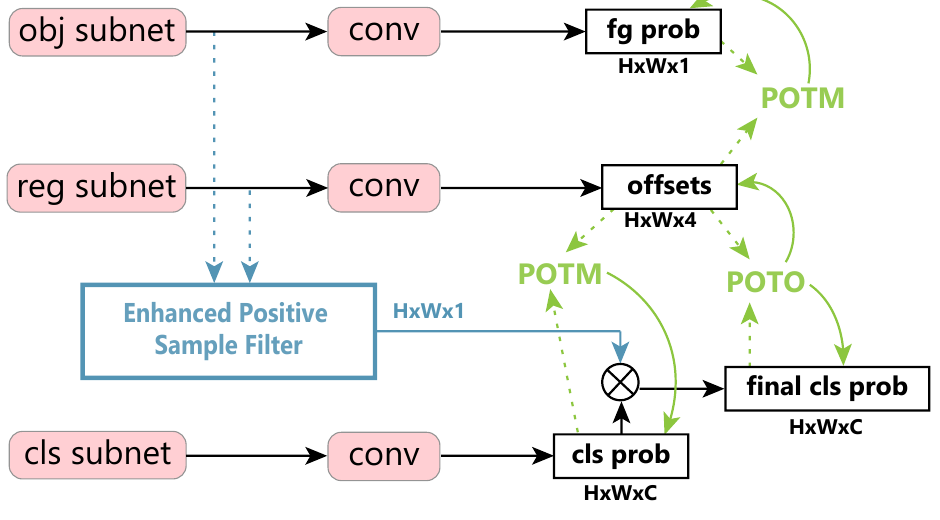
Figure 2. The diagram of label assignments.‘POTO’ and ‘POTM’ denote prediction-aware one- to-one and one-to-many label assignments, respectively, which are based on the qualities of both classification and regression. The green dashed lines connect the predictions to ‘POTO’ or ‘POTM’, which means the qualities are computed based on these predictions. The green solid lines connect ‘POTO’ or ‘POTM’ to predictions, which represents ‘POTO’ or ‘POTM’ generating training targets for these predictions. The ‘obj subnet, ‘reg subnet’ and ‘cls subnet’ mean the four convolutional layers on top of FPN feature maps in objectiveness, regression, classification branches,